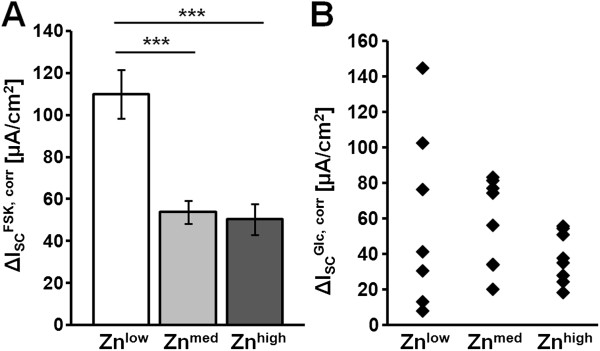
Active transport of jejunal epithelium at 1 dpi. All values were corrected for the epithelial surface area (corr). (A) Stimulation by forskolin (FSK) resulted in a significantly increased chloride secretory response (∆ISCFSK, corr) in the Znlow group (P ≤ 0.001, n = 8) when compared to the Znmed (n = 9) and Znhigh groups (n = 10). (B) Glucose-induced short-circuit currents (∆ISCGlc, corr) of Znlow (n = 7), Znmed (n = 8), and Znhigh (n = 8) were not significantly different. Note the big spread of individual values in the Znlow group.